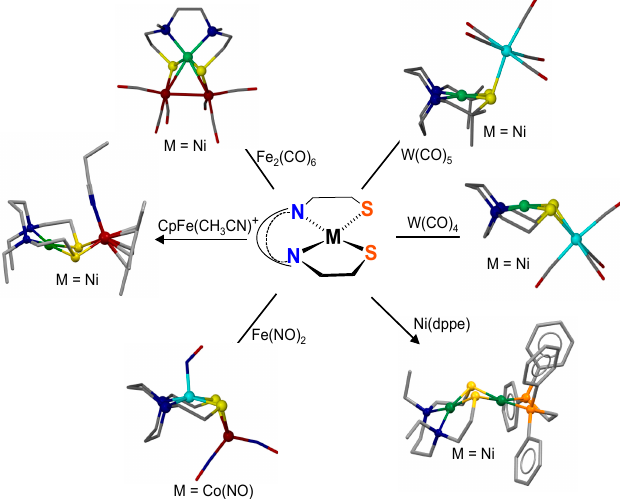
Figure 2. Examples of bi- and trimetallic complexes accessed by connecting the MN 2 S 2 metallodithiolate ligand to various transition metal receivers, adapted from [7].